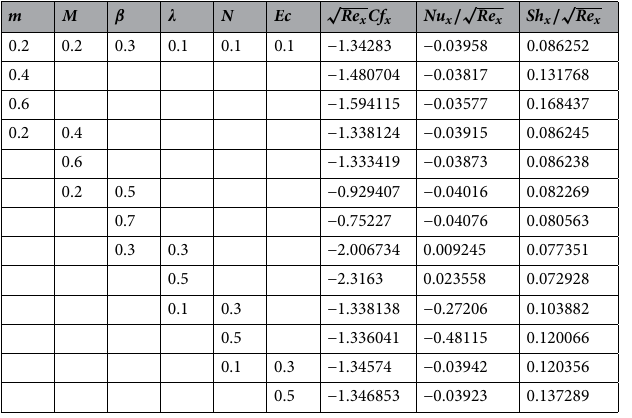
Table 3. The values of √ Re x Cf x , Nu x / √ Re x , and Sh x / √ Re x , for diverse values of m , M , β , (cid:31) , N and Ec , other values are n = 0.2, β = 0.3, M = 0.2, ξ = 0.2, Rd = 0.5, Pr = 0.71, N b = 0.1, N t = 0.1, α 1 = 0.1, Le = 0.8, k 1 = 0.1, E = 2, δ = 0.5, m = 0.5, Bi 1 = 0.1, Bi 2 = 0.1, B r = 0.5, (cid:31) 1 = 2, χ = 2.